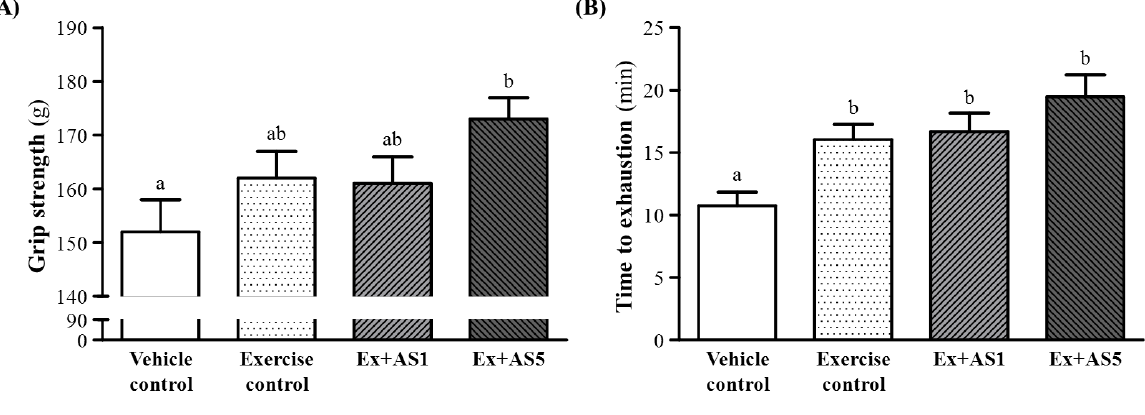
Figure 2. Effect of AS supplementation on forelimb grip strength ( A ) and endurance swimming time ( B ). Data are mean ± SEM of 10 mice in each group by one-way ANOVA. Different letters (a and b) indicate significant difference at p <